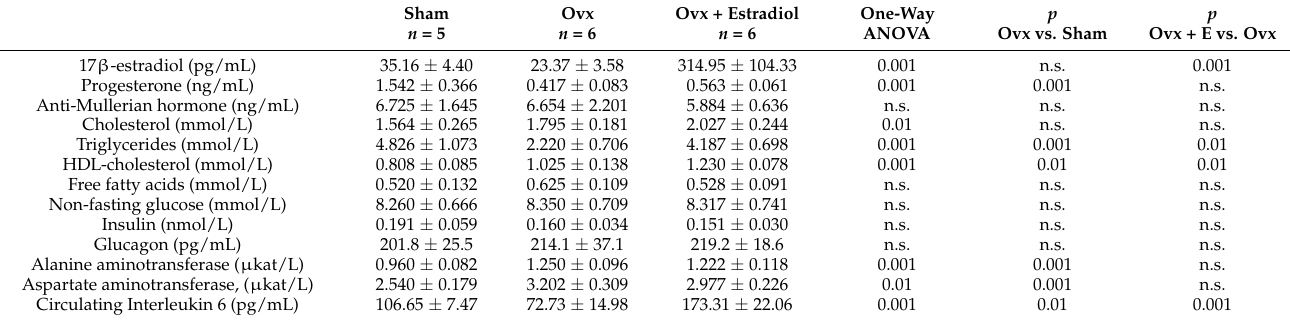
Table 2. Differences after Ovariectomy and Estradiol Substitution in Circulating Metabolic and Inflammatory Parameters in Serum in Hereditary Hypertriglyceridemic Rats.